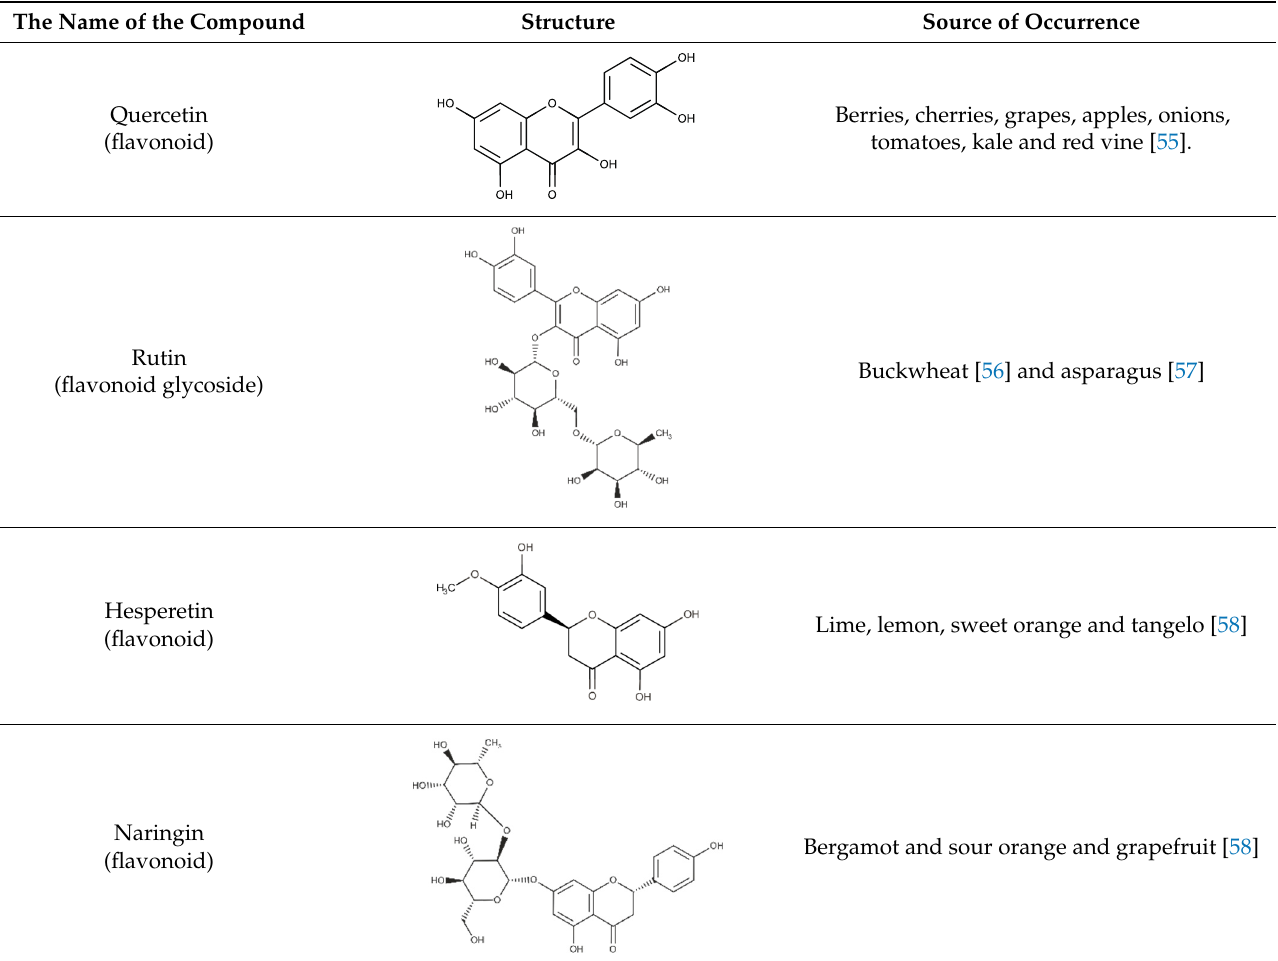
Table 1. Selected important polyphenolic compounds and their sources in the diet.